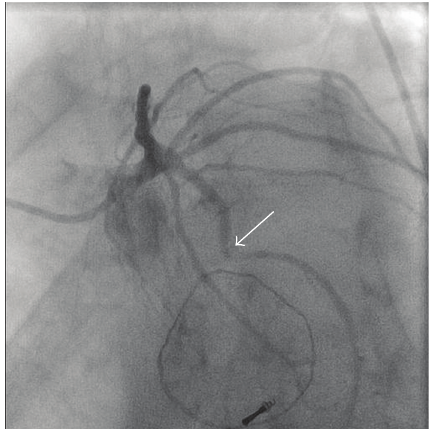
Figure 1: Kinked circumflex artery (arrow) secondary to suture distortionfromarecentlyrepairedmitralvalve.Leftanterioroblique with caudal angulation.